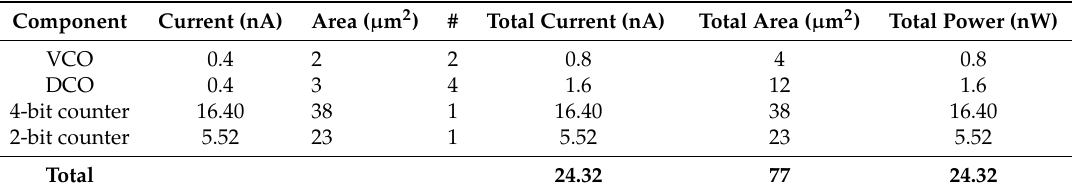
Table 1. Estimated power consumption and occupied area per channel, V DD = 1